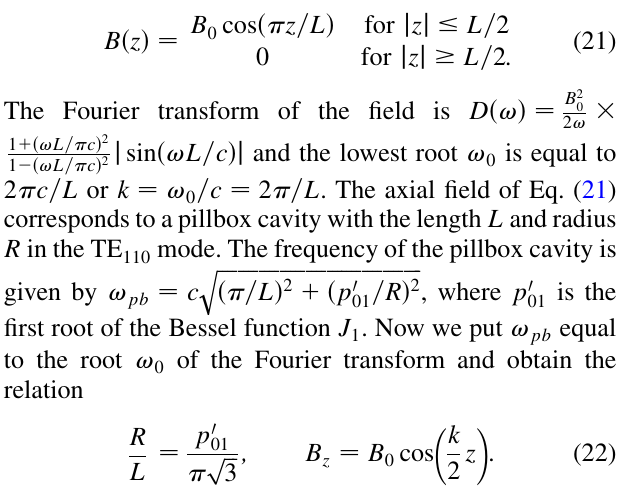
FIG. 2. (Color) Shape, field pattern, the axis, and surface fields cell superconducting cavity of the rf gun having TE of 3 1 2 mode with the frequency of 3781 axis and surface fields of the corresponding TE modes. In